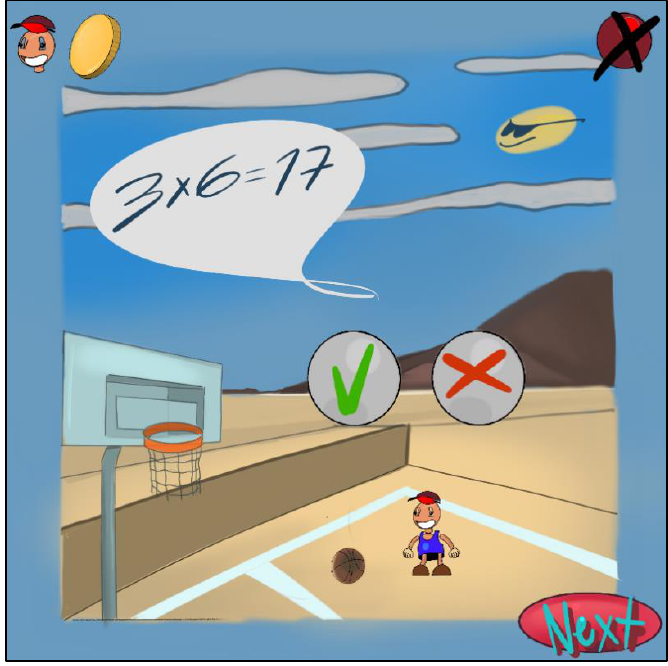
Figure 1. Right/wrong question in first scene. Figure 1. Right / wrong question in first